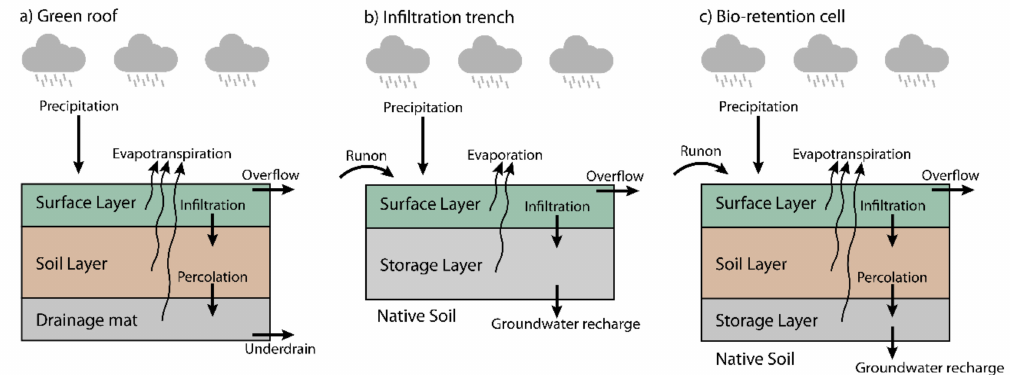
Figure 1. Layer concept and simulated processes in Storm Water Management Model (SWMM) for ( a ) green roof, ( b ) infiltration trench, and ( c ) bio-retention